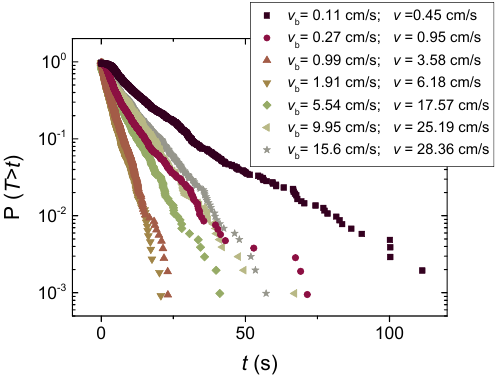
Figure 2. Experimental survival functions of the avalanche du- rations for an outlet size of D = 1 . 53 cm ( D / d p = 3 . 82) and the typical particle velocities displayed in the legend.